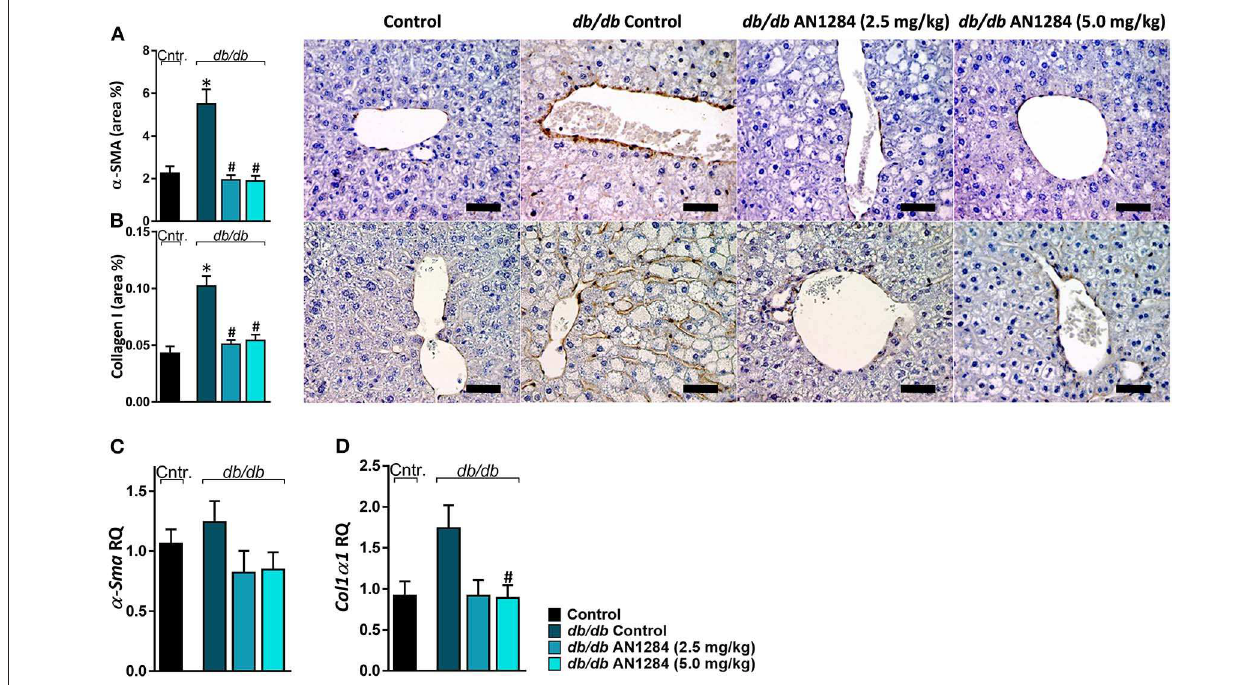
FIGURE 7 | AN1284 mitigates hepatic fibrosis in db/db mice. Untreated db/db animals exhibited increased protein and mRNA expression levels of the fibrotic markers α -SMA (A,C) and Collagen I (B,D) , which were normalized in AN1284-treated mice. Scale bar, 50 µ m. Data represent the mean ± SEM from 8 to 10 mice